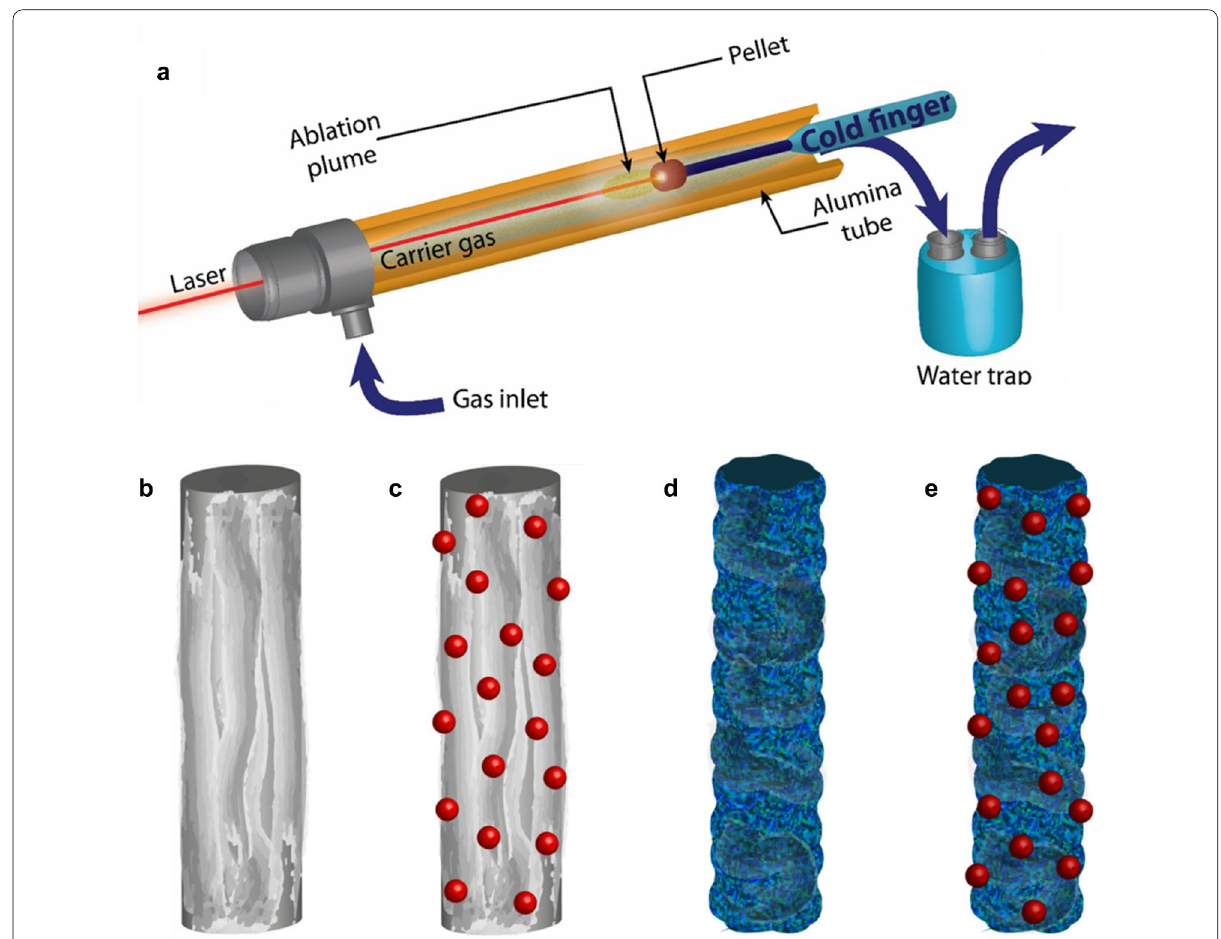
Fig. 1 Overview of the laser ablation setup and the nanowires. a Schematic drawing of the laser ablation setup used to synthesize distinct types of boron‑based nanowires. A pellet held by a holder connected to a cold finger is inserted into an alumina tube chamber while the laser enters the chamber at the other extreme. b – e Schematic drawings of the microstuctural morphology of the various types of nanowires produced in the setup in a . Four basic type of morphologies are observed: fibrous and “bare” ( b ), fibrous and decorated with nanoparticles ( c ), coarse and bare ( d ) and coarse and decorated with nanoparticles ( e